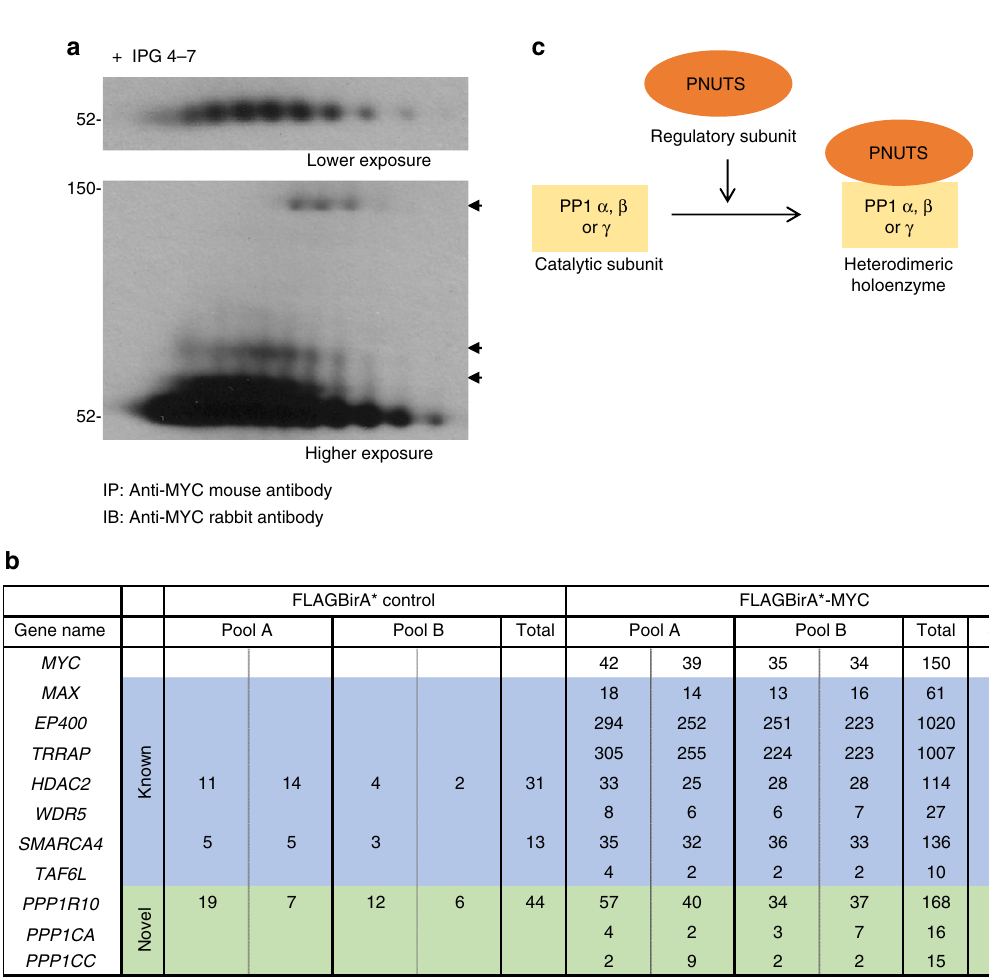
Fig. 1 MYC is post-translationally modi fi ed and interacts with the PP1/PNUTS phosphatase complex. a Cell lysate from growing MCF10A cells was immunoprecipitated with MYC monoclonal mouse antibody, resolved by 2D gel electrophoresis (7 cm, pH 4 – 7 IPG strip; 10% SDS-PAGE), transferred onto nitrocellulose membrane and immunoblotted with MYC polyclonal rabbit antibody. Representative image of n = 3. Shown is lower exposure (top panel) and higher exposure (bottom panel) x-ray fi lm images. Arrows show numerous high molecular weight MYC spots. b Shown are the gene names and spectral counts of selected known and novel MYC interacting proteins identi fi ed by conducting MYC-BioID MS in HeLa cells. A and B are biological replicates with two technical replicates shown for each. Total spectral counts and SAINT analysis score are presented. Signi fi cance is achieved with